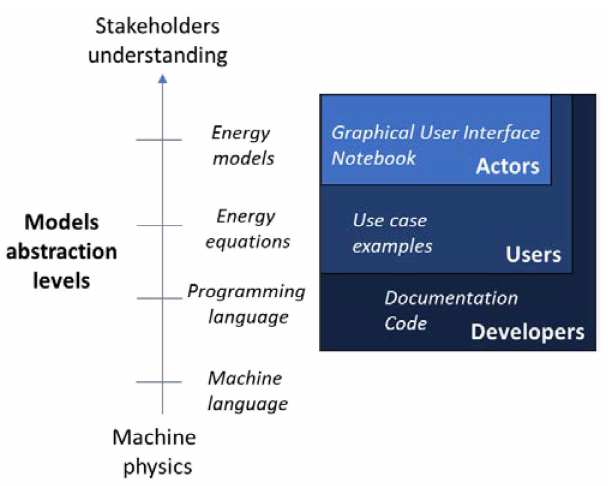
Figure 2. Abstraction levels of models with respect to stakeholders’